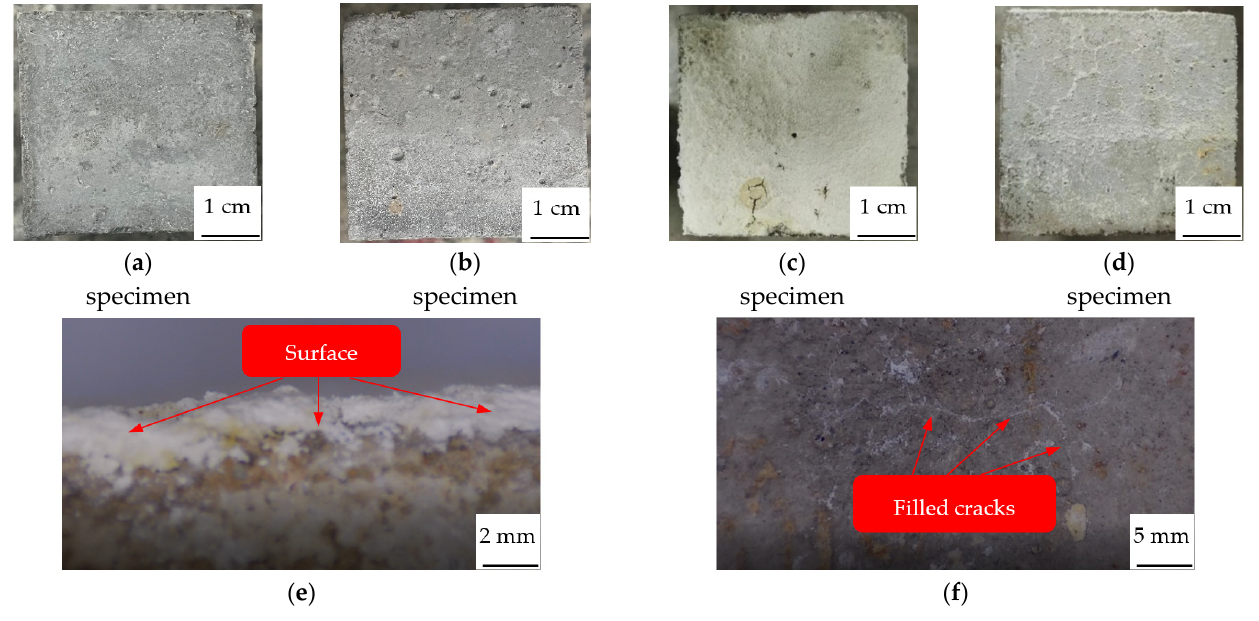
Figure 8. Apparent characteristics of concrete specimen. ( a ) Undamaged. ( b ) Damaged. ( c ) Upper surface of repaired. ( d ) Side of repaired. ( e ) Surface film. ( f ) Repaired cracks. Compared with the undamaged specimen (Figure 8a), there are many cracks and pores caused by high temperature; these cracks and pores irregularly distribute on the surface of the damaged specimen (Figure 8b). The cracks connected with each other, the widest reaches 524.57 µ m in width, the largest pore reaches 2.26 mm in diameter. However, after repair, the upper surface (Figure 8c) of the specimen is totally covered with two layers of white sediments; cracks and pores are completely filled with the sediments. The particles from the upper layer are large and dispersed, whereas the particles from the bottom layer are compact and continuous with good cohesiveness. These two layers of white sediments will be analyzed in Sections 3.2 and 3.3. The sides (Figure 8d) of the specimen are also covered with a continuous layer of white sediments but not as thick as the upper surface; cracks and pores are also completely filled with the